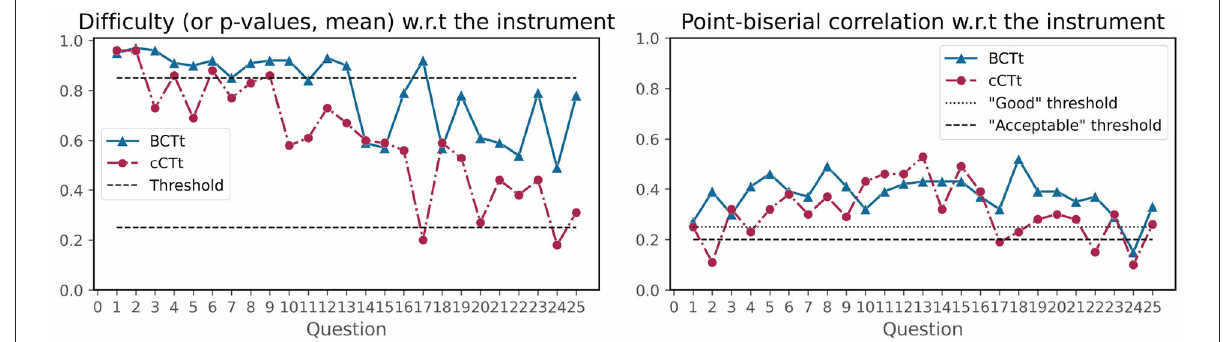
FIGURE4 Classical Test Theory—Item Difficulty indices (i.e., the proportion of correct responses) on the left, and Point-Biserial Correlation on the right. Items with difficulty indices above the 0.85 threshold are considered too easy while items with difficulty indices below the 0.25 threshold are considered too difficult. Items with a point-biserial correlation above the 0.2 threshold are considered acceptable while those above 0.25 are considered good.